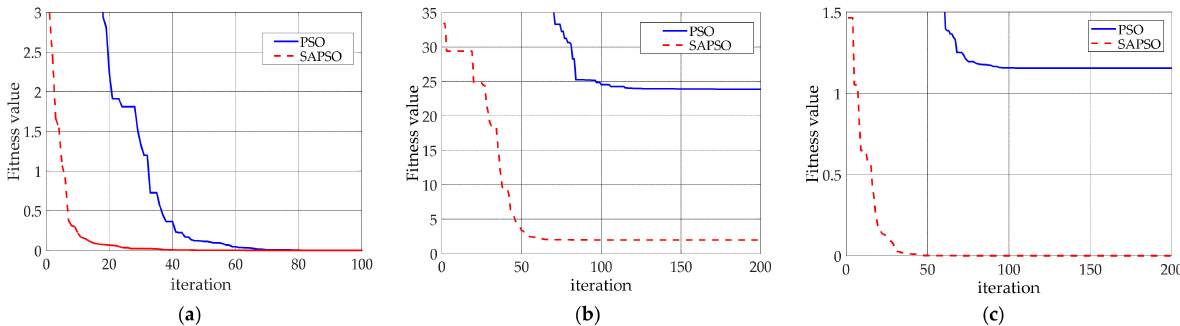
Figure 2. ( a ) Convergence curves of PSO and SAPSO algorithms for solving the sphere function. ( b ) Convergence curves of PSO and SAPSO algorithms for solving the Rastrigrin function. ( c ) Convergence curves of PSO and SAPSO algorithms for solving the Ackley